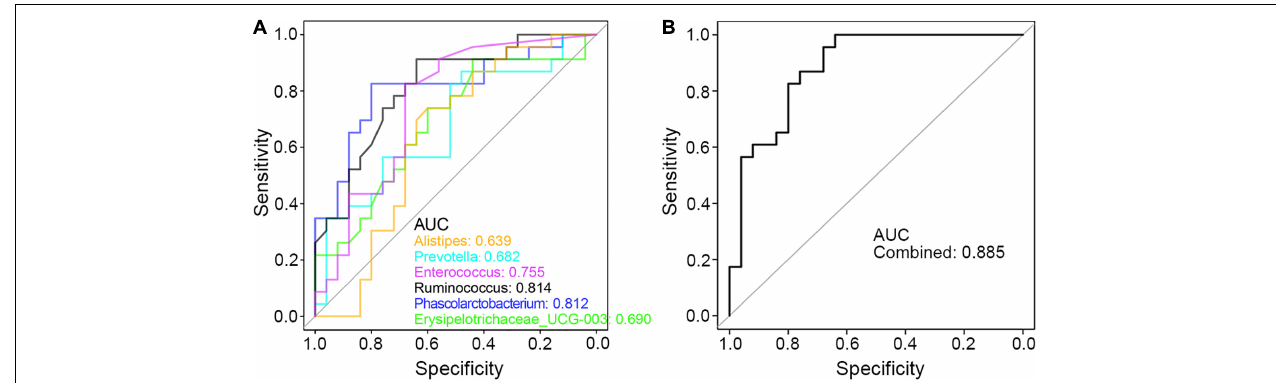
FIGURE 7 | ROC curve in discriminating PCD and Non-PCD by diarrhea-related genera. Area under curve (AUC) of single (A) and combined (B) genus taxon, respectively, in discriminating PCD and Non-PCD.